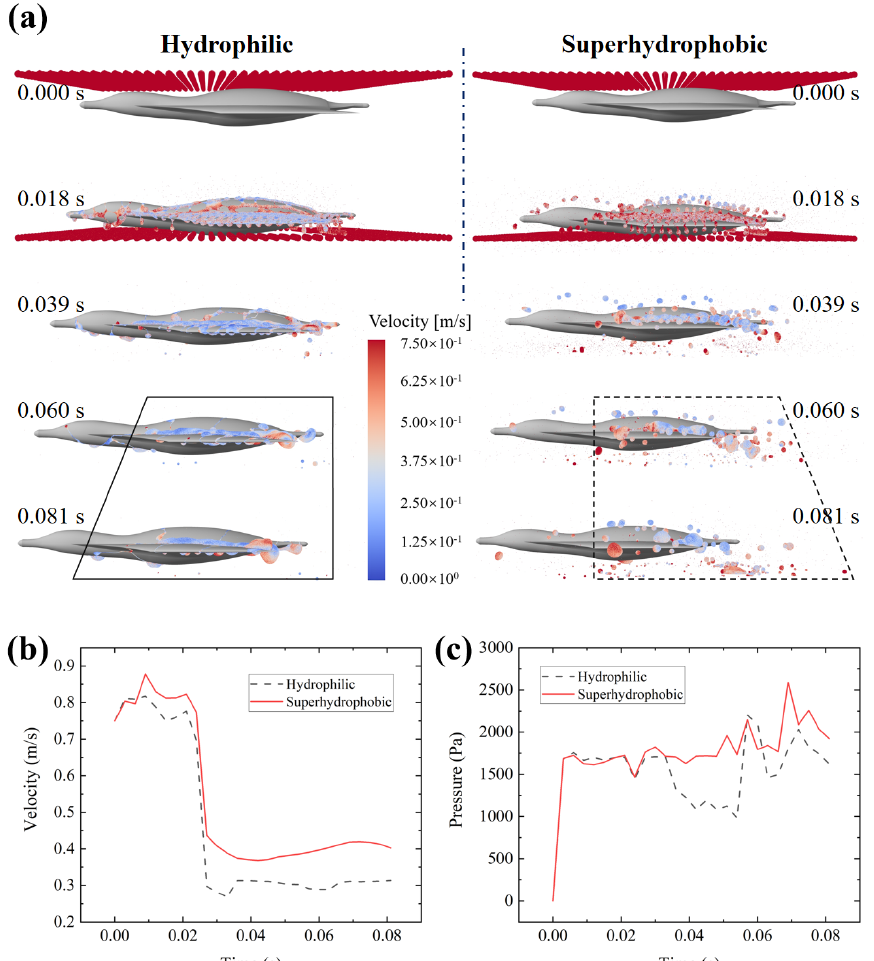
Figure 7. Simulation and comparative analysis of the effect of surface wettability on antiwetting. ( a ) Antiwetting properties of moving hydrophilic and superhydrophobic surfaces. The trapezoidal regions indicate a hydrophilic surface producing continuous backward-moving liquid films. How- ever, on the superhydrophobic surfaces, no wetting was observed, and the raindrops bounced off downstream. ( b ) and ( c ) show the velocity and pressure fields, respectively. Overall, hydrophilicity reduces velocity and pressure, while superhydrophobicity and mobile coupling provide the droplet with sufficient energy to bounce